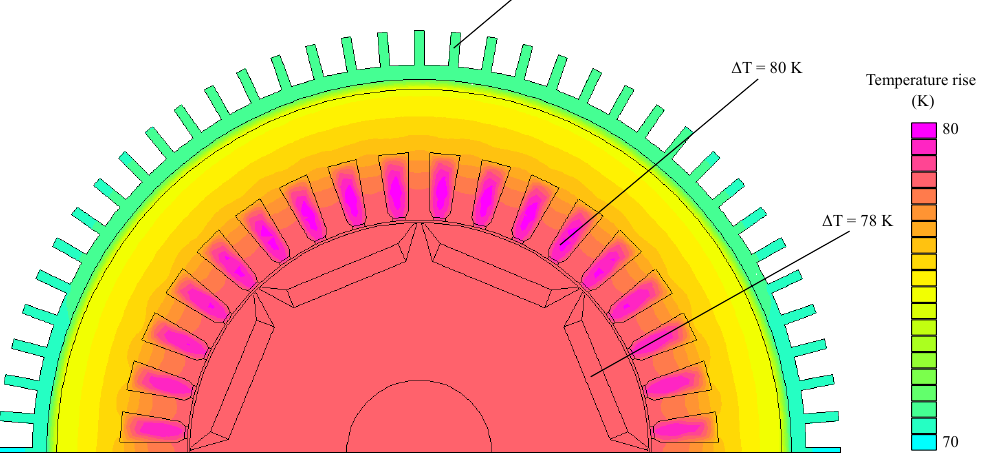
Figure 31. Temperature increase map for the HEPM motor with a forced-air cooling system.